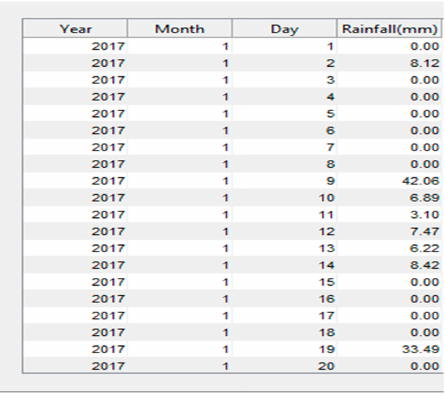
Figure 7. Example of a one-year simulation of daily sequences of climate variables using the CCSM4 model under the RCP4.5 scenario (1 January–31 December 2017).